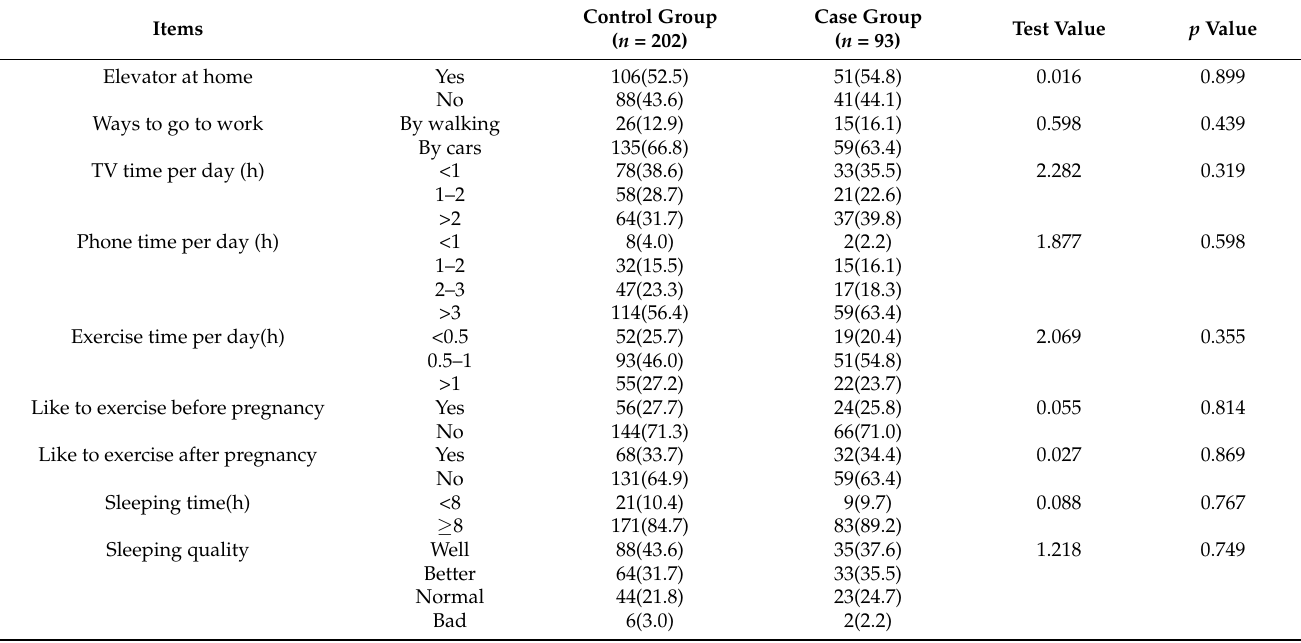
Table 9. Comparison of pregnant women’s exercise and sleep conditions between the control and case groups ( n ,